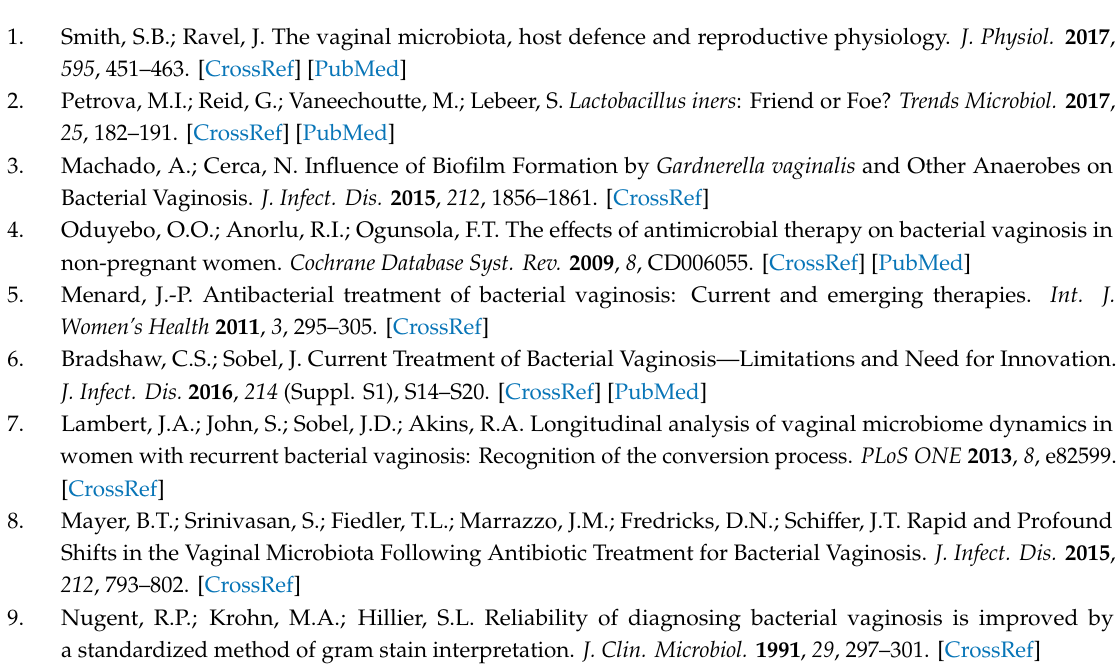
Table S1: Nugent scores of participants in the Group 2 on Days 1 (baseline), 8, and 15. Figure S1. Distribution of vaginal microbiota community state types (CSTs) in combined study groups by hierarchical clustering (Group 1: healthy women; Group 2; women diagnosed with